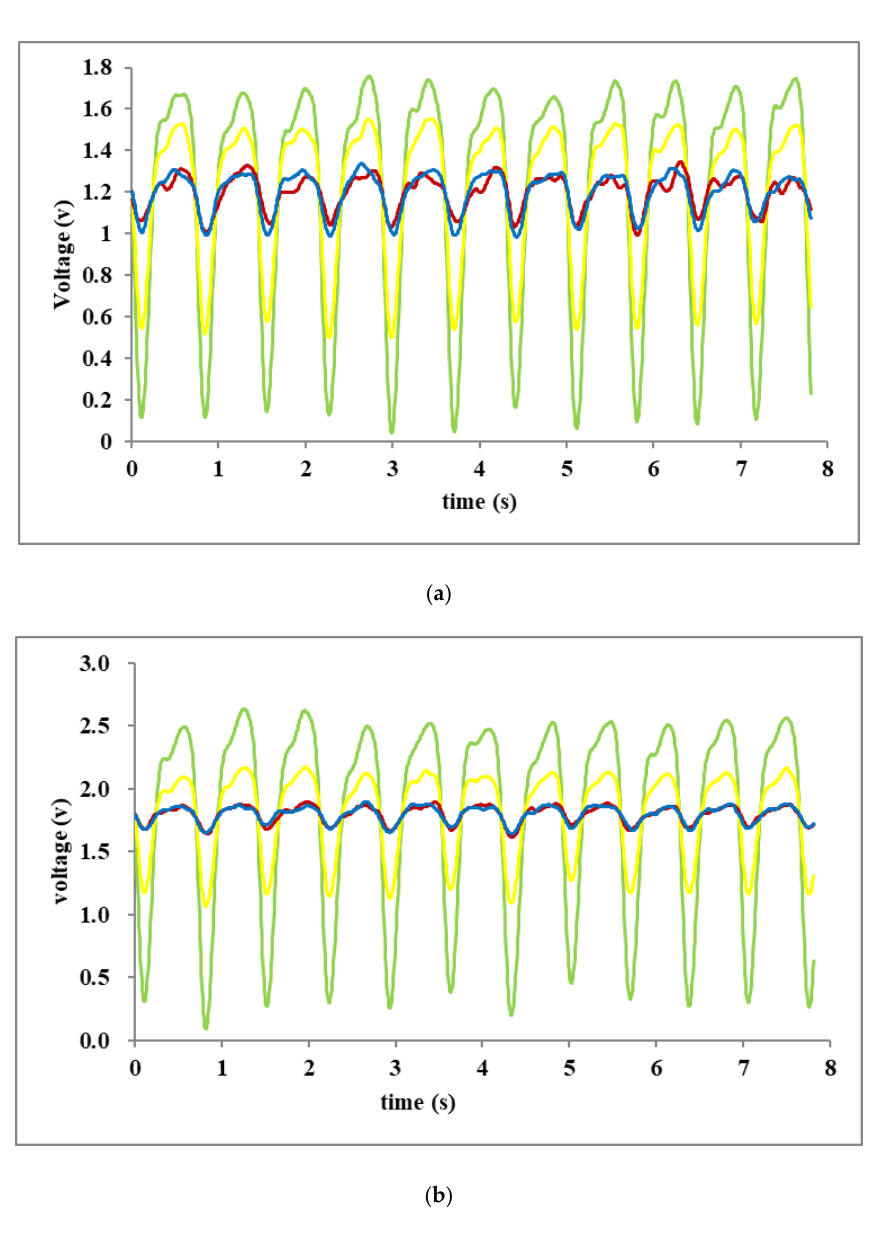
Figure 8. The PD signals received from a subject at rest. Note that green signal is the signal received from the green LED illumination; orange from the orange LED illumination; red from the red LED illumination; and brown from the infrared LED illumination: ( a ) the AAOV not applied; and ( b ) the AAOV applied.